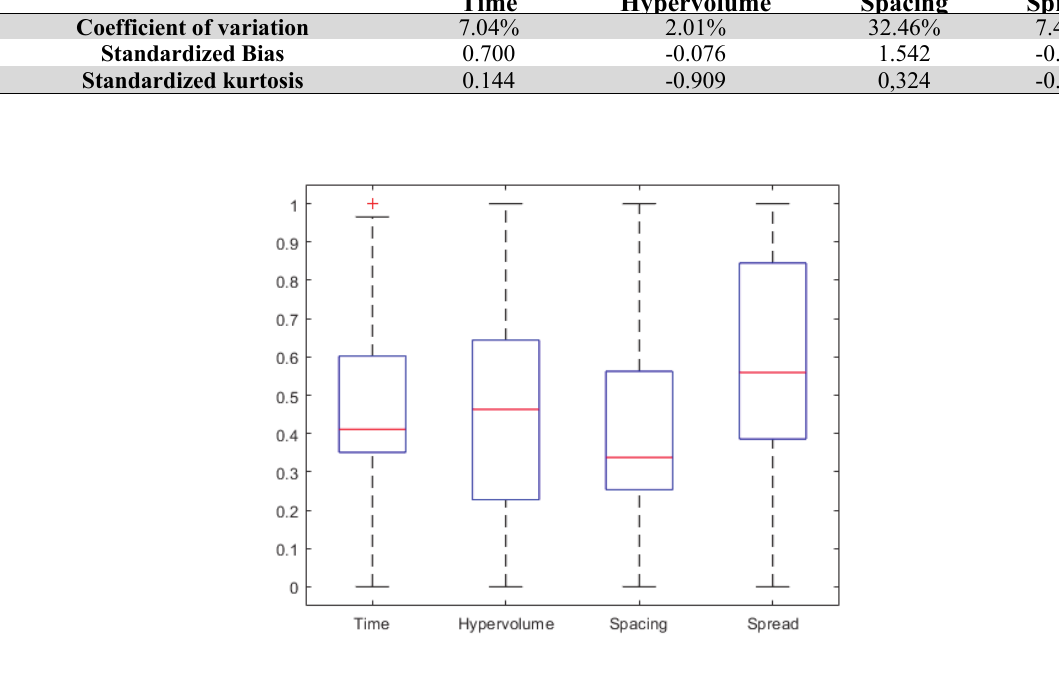
Fig. 3. Pareto metric